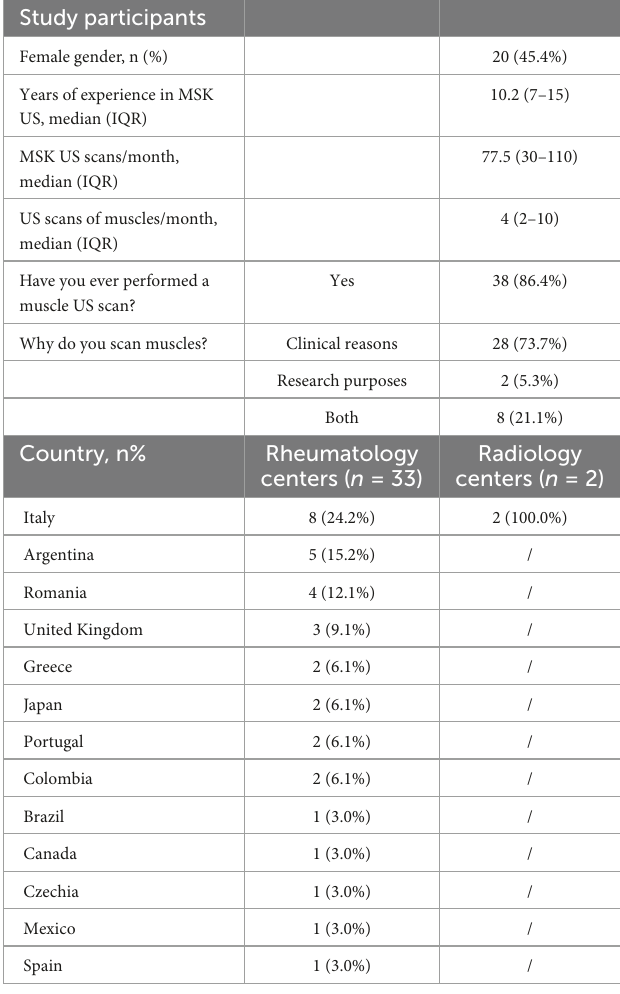
TABLE 1 Main information of the participants in the study ( n = 44). Study participants